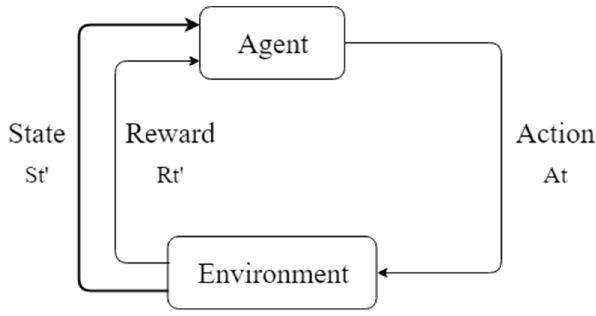
Figure 2. Process flow of Markov Decision Processes (MDPs).